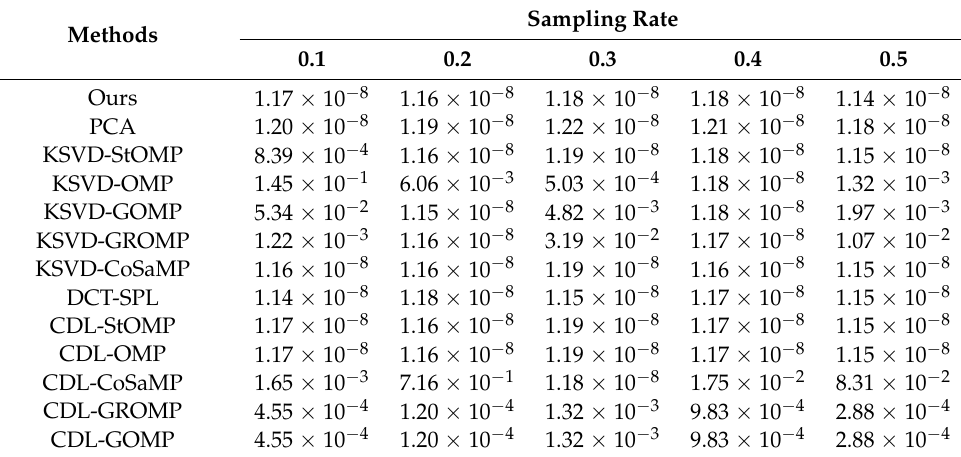
Table 2. The reconstructed average Spectral Angle Mapper (SAM) (Scientific notation) of hyperspec- tral images in all bands under different sampling